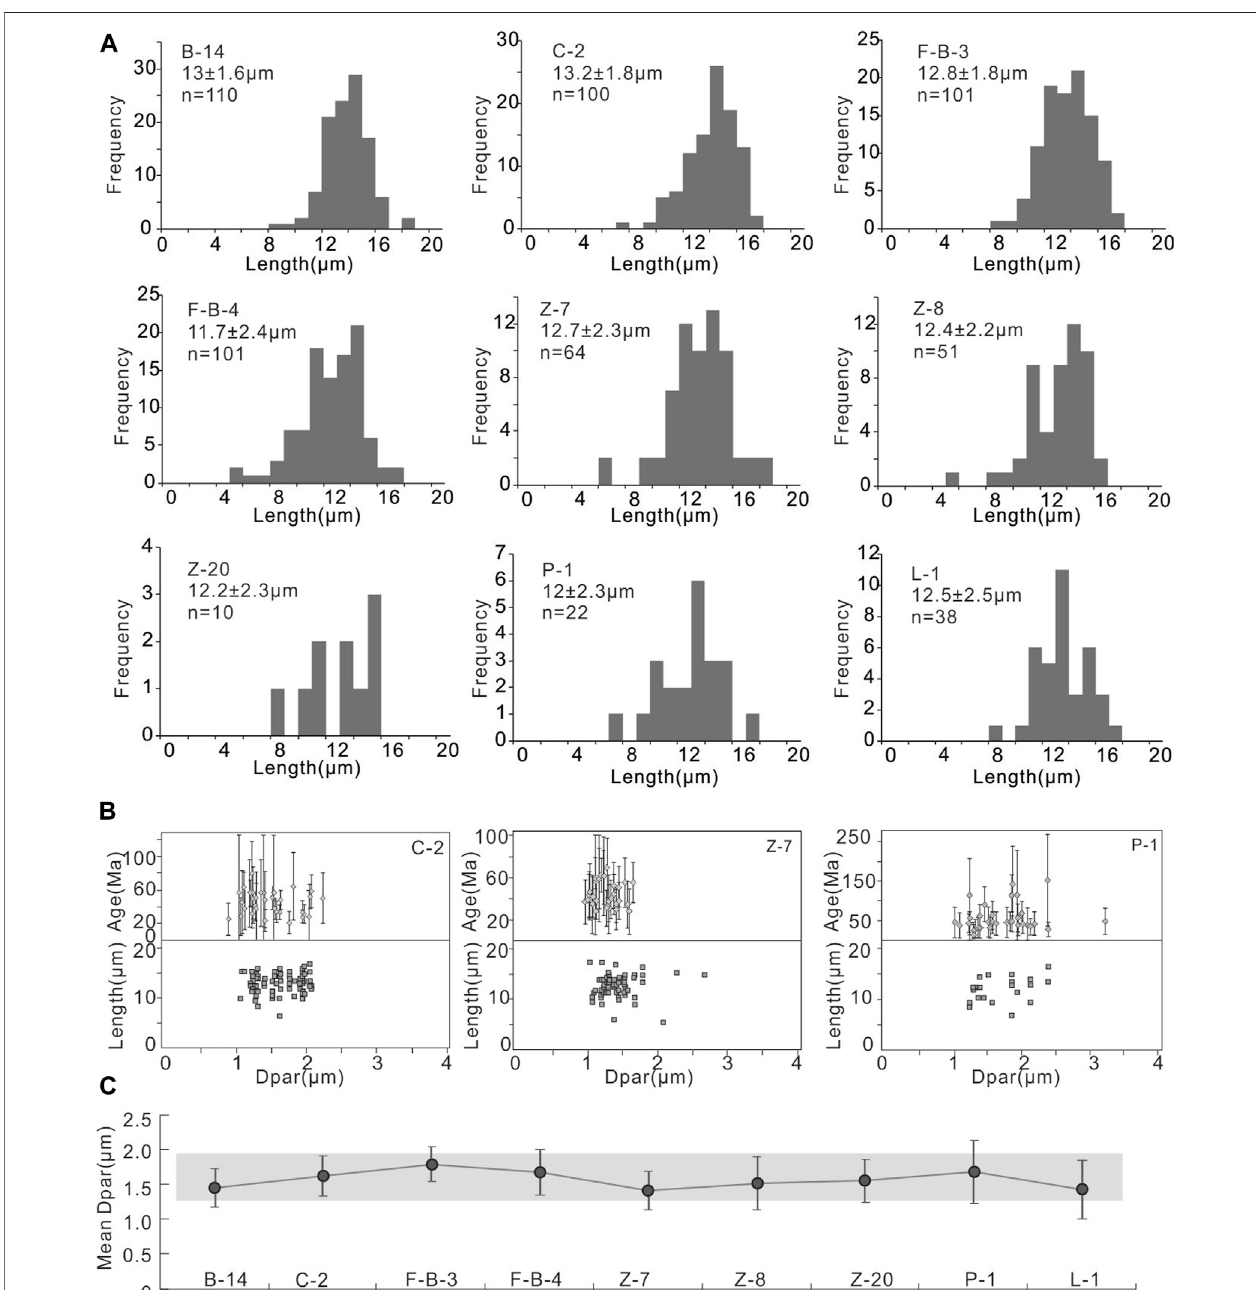
FIGURE 3 | (A) Histogram of the measured track length distribution of all samples, (B) relationship between Dpar and length and ages, taking samples C-2, Z-7, and P-1 for example, (C) Dpar plots of samples.